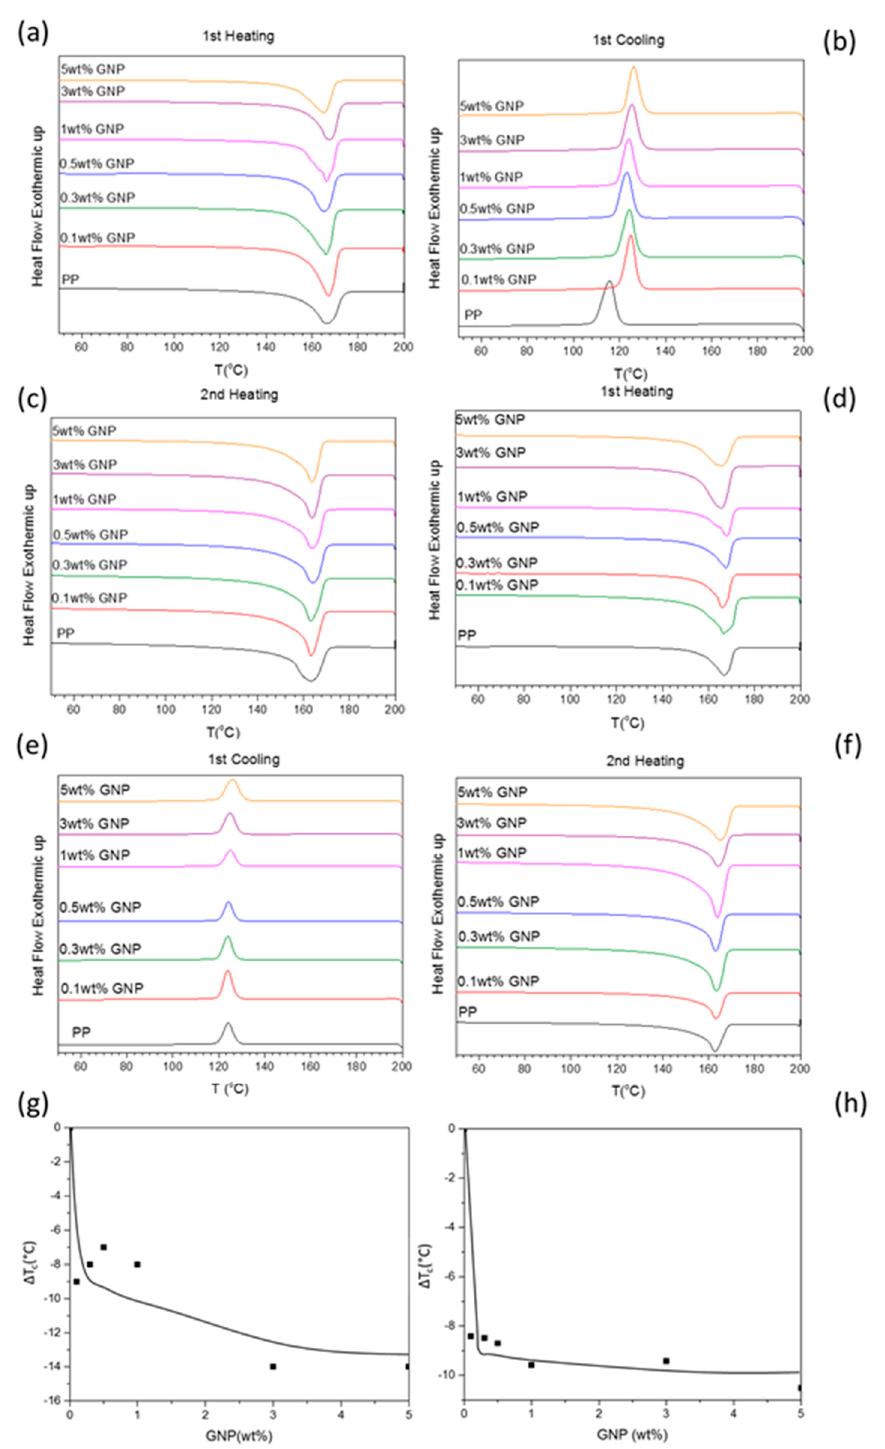
Figure 4. Differential scanning calorimetry (DSC) thermograms (heating and cooling) of composites of PP with GNPs at different loadings prepared using a laboratory scale extruder ( a – c ) and a 16-mm extruder ( d – f ) and the change in crystallization temperature ( ∆ T c ) as a function of GNP loading for the samples prepared with a laboratory scale extruder ( g ) and a 16-mm extruder ( h ).